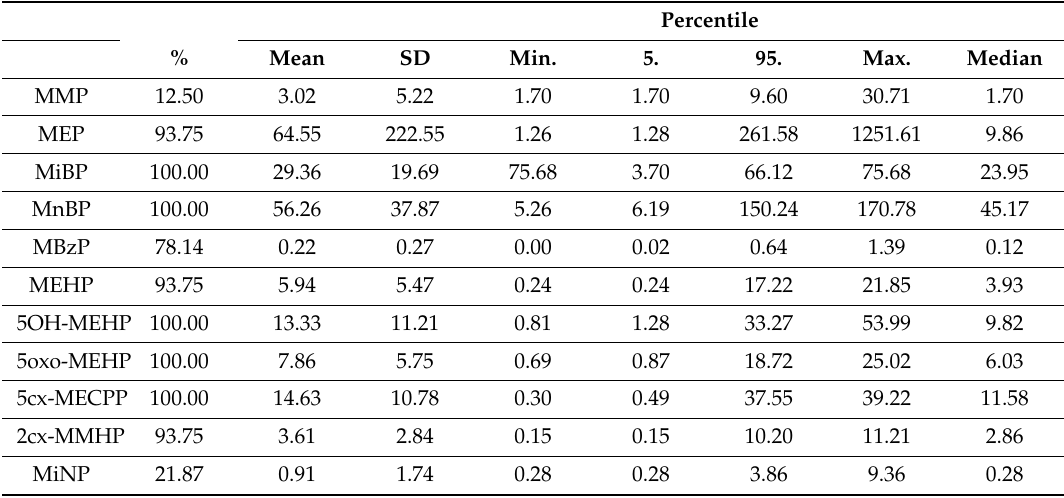
Table 3. Descriptive statistic of urinary phthalate metabolite ( µ g / L).